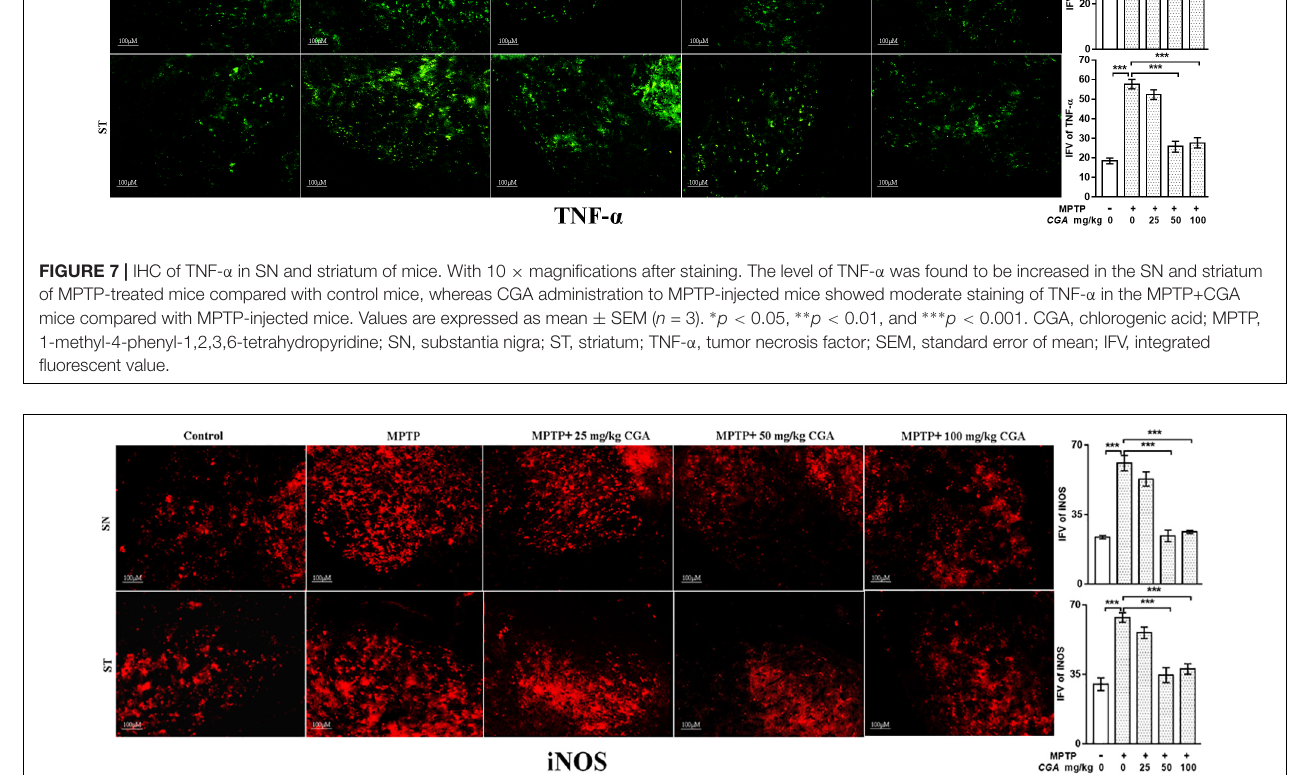
FIGURE 8 | IHC of iNOS in the SN and striatum of mice. With 10 × magnifications after staining. The increased expression of iNOS in the SN and striatum was found in the MPTP-treated mice compared with control mice, whereas CGA supplementation reduced the expression of iNOS mice compared with MPTP-intoxicated mice. Values are expressed as mean ± SEM ( n = 3). ∗ p < 0.05, ∗∗ p < 0.01, and ∗∗∗ p < 0.001. CGA, chlorogenic acid; MPTP, 1-methyl-4-phenyl-1,2,3,6-tetrahydropyridine; SN, substantia nigra; ST, striatum; iNOS, inducible nitric oxide synthase; SEM, standard error of mean; IFV, integrated fluorescent